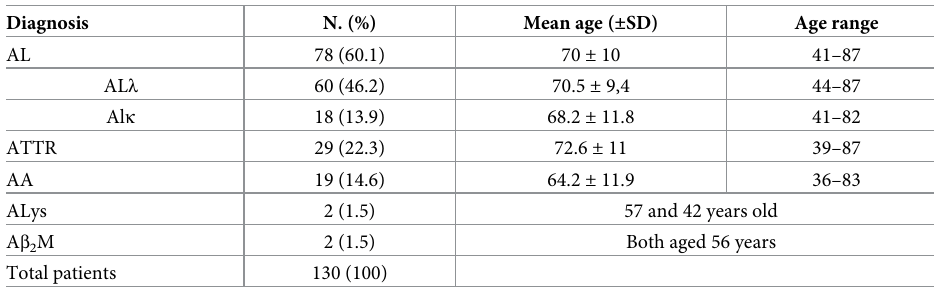
Table 3. Amyloidosis